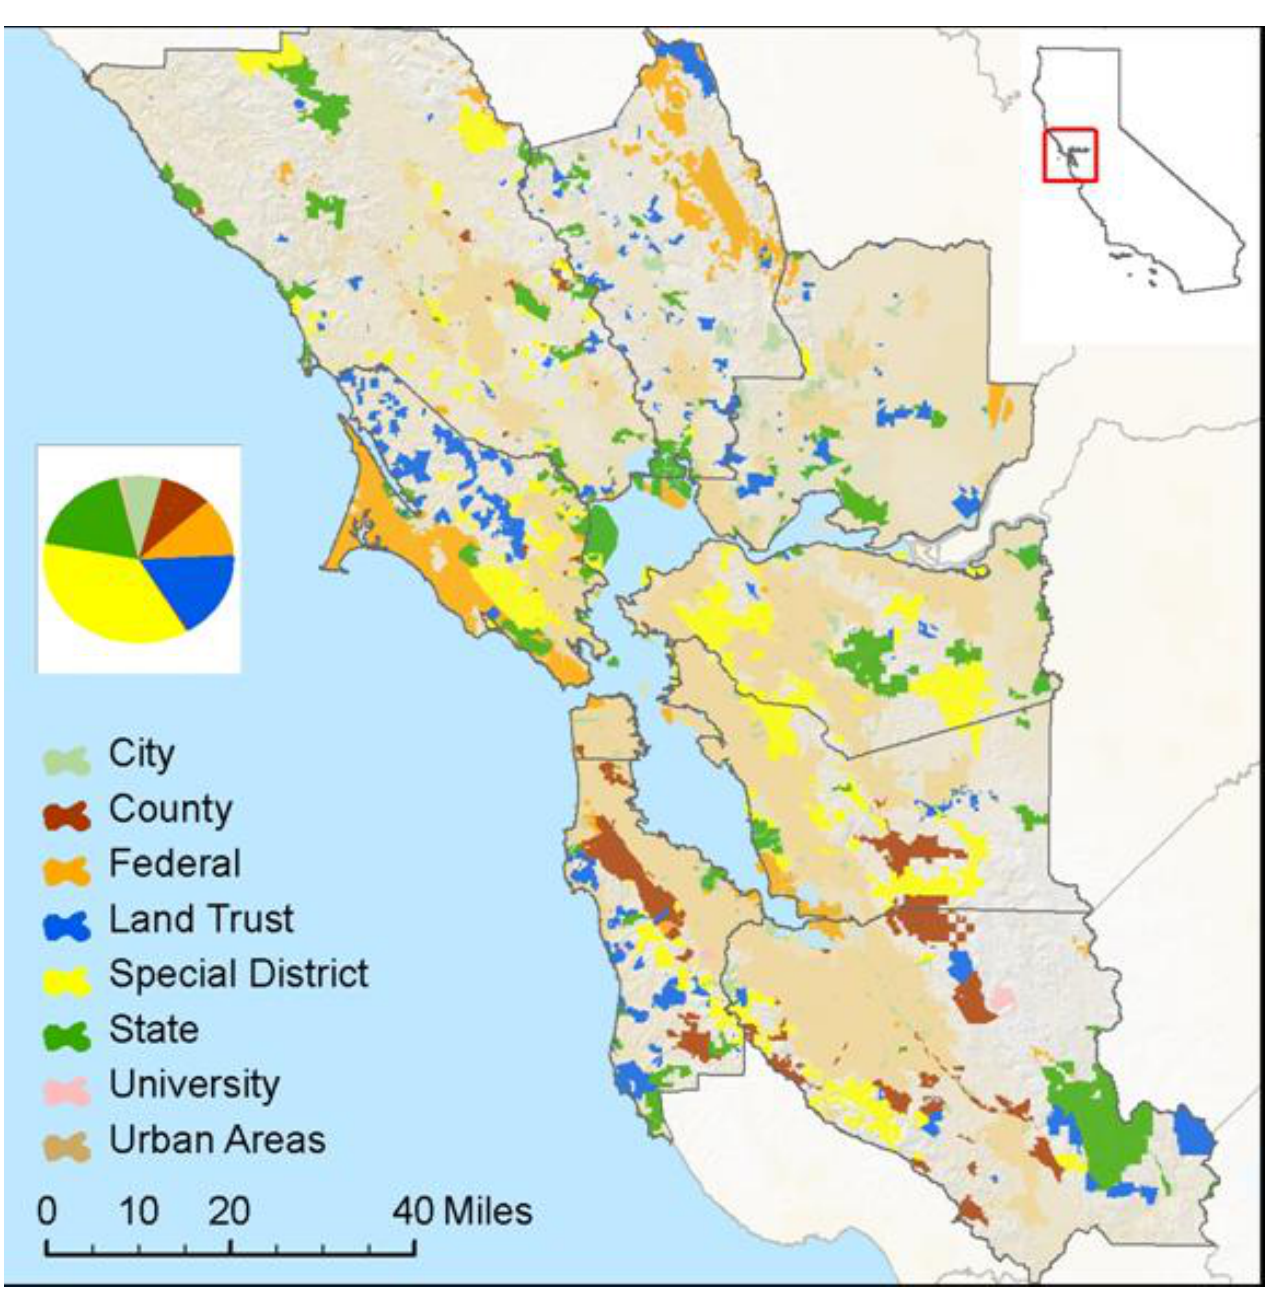
Fig. 3 . Owners of protected areas in the San Francisco Bay